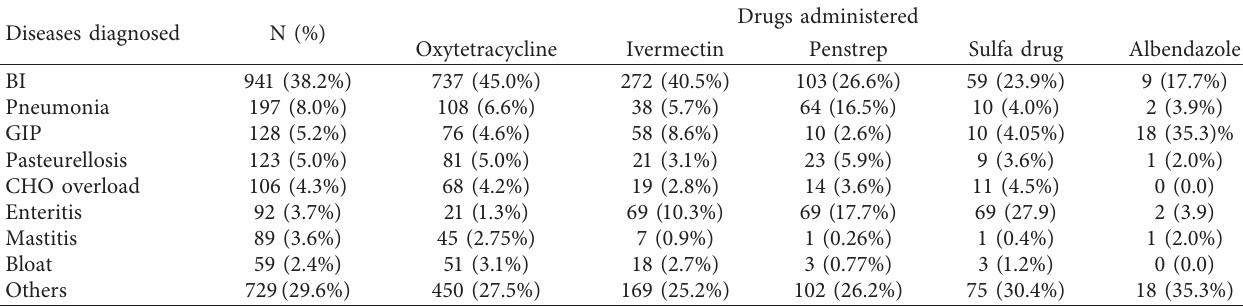
Table 3: Association between diseases and drugs administered at Batu and Arsi-Negelle district veterinary clinics. Diseases diagnosed